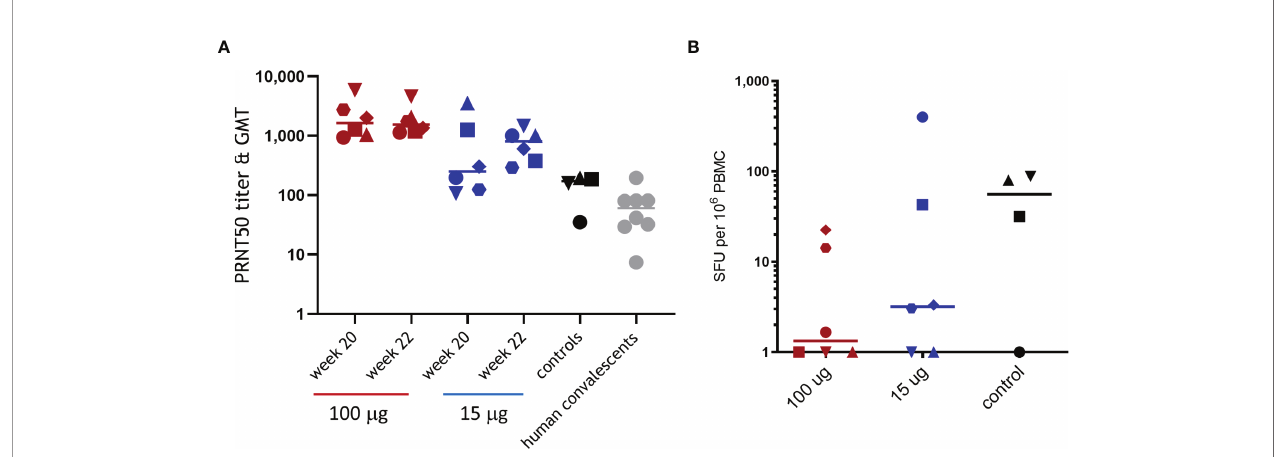
FIGURE 4 | Immune responses following SARS-CoV-2 challenge. Rhesus macaques were vaccinated and challenged as described in Figure 2 . SARS-CoV-2 neutralizing antibodies (A) were measured at the time of challenge (week 20) and 2 weeks post-challenge (week 22) by PRNT, and RBD-speci fi c IFN- g T-cell responses (B) were measured 2 weeks post-challenge by ELISpot. (A) Symbols represent individual PRNT50 titers; horizontal bars depict the GMT of the group. For comparison, PRNT50 titers and GMT of 10 human plasma samples positive for SARS-CoV-2 antibodies (human convalescents) are shown. (B) Symbols represent individual spot-forming units (SFU) per one million PBMCs; horizontal bars depict mean SFU per one million PBMCs. Different symbol shapes represent individual animals, and the same symbol shapes are used for the same animals throughout all post-challenge data.